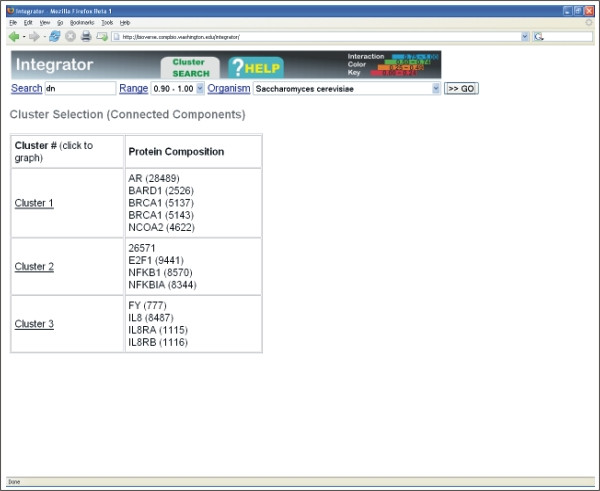
Multiple protein identifier search results. A representative search result where three clusters (defined by connected graph components) are shown with their constituent nodes. Each of the individual clusters can be viewed graphically by following their hyperlinks.